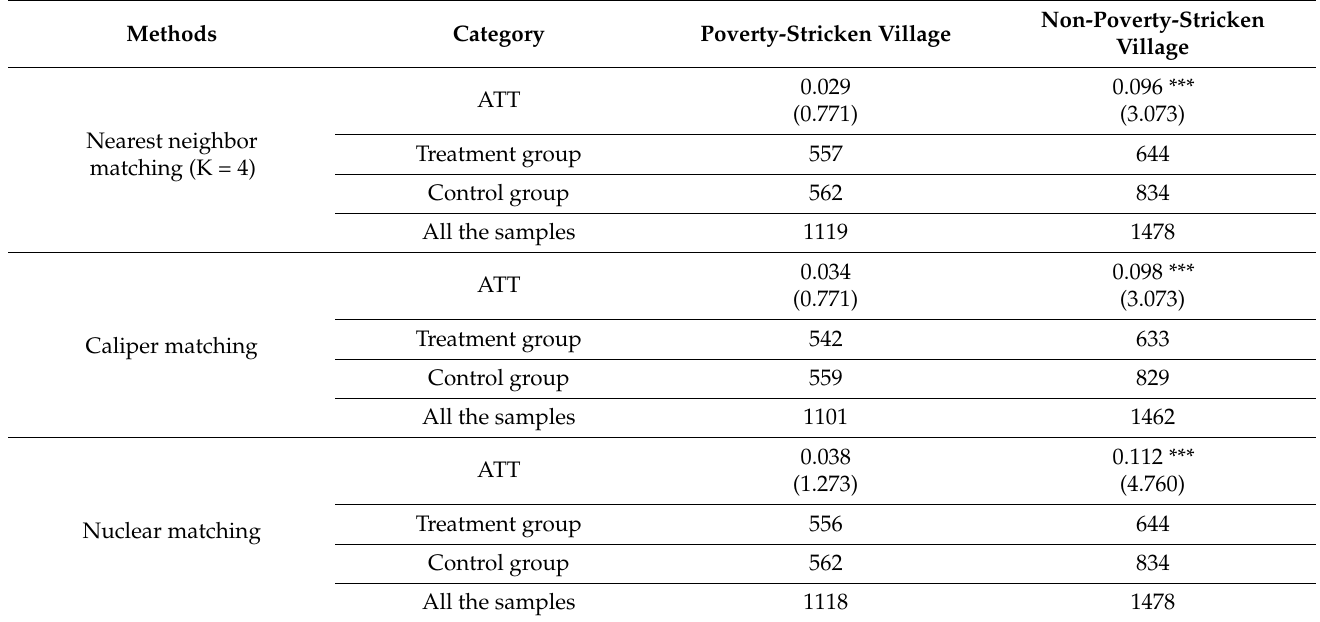
Table 9. Attribute heterogeneity of